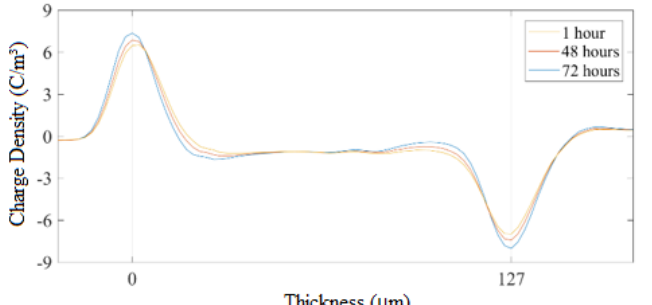
Figure 11. Space charge profiles in a single layer Kapton specimen under 5 kV DCP with δ = 0.6 after 1, 48 and 72 h.